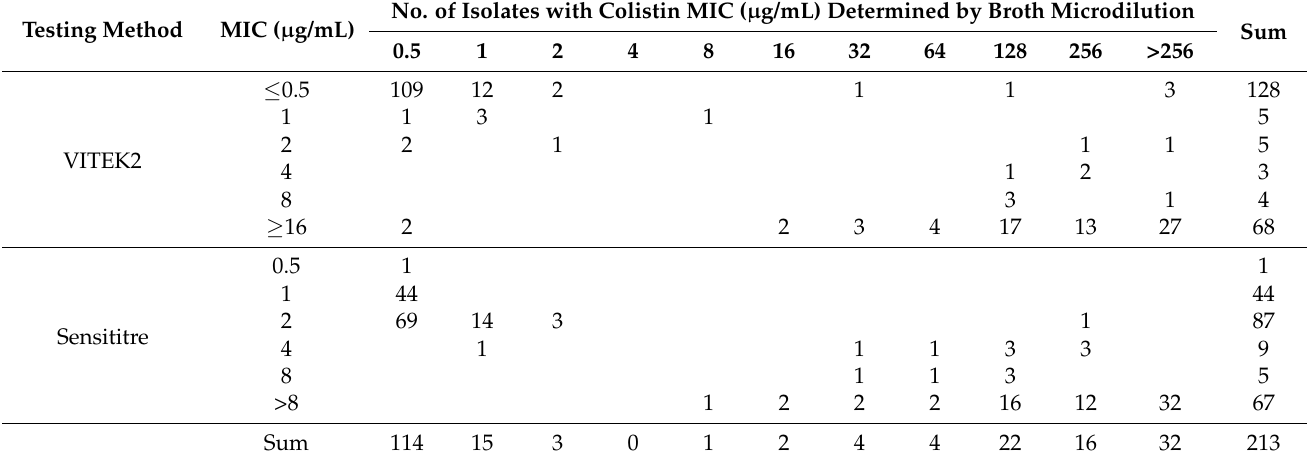
Table 2. Colistin MICs of VITEK2 and Sensititre system compared to broth